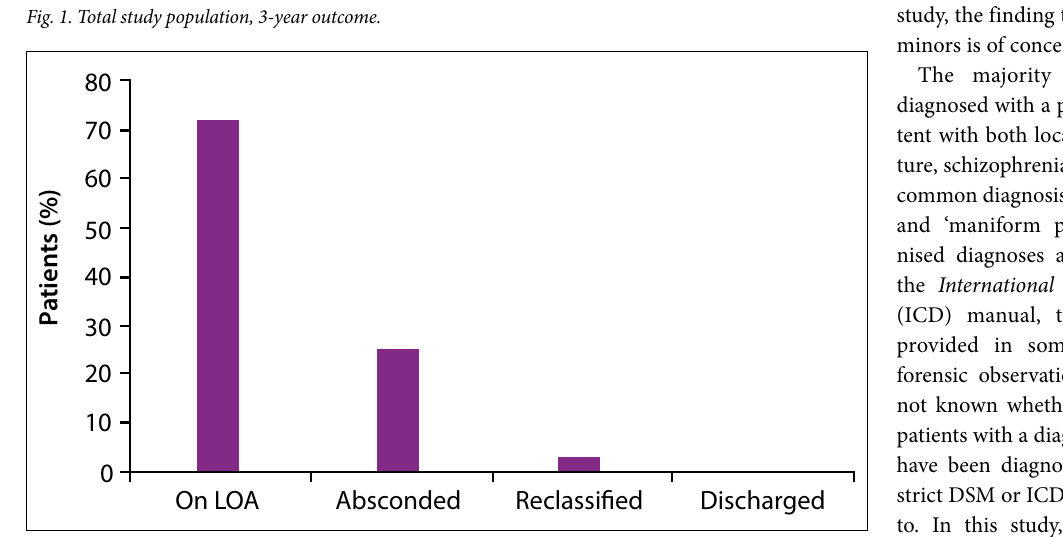
Fig. 2. State patients in the community after 3